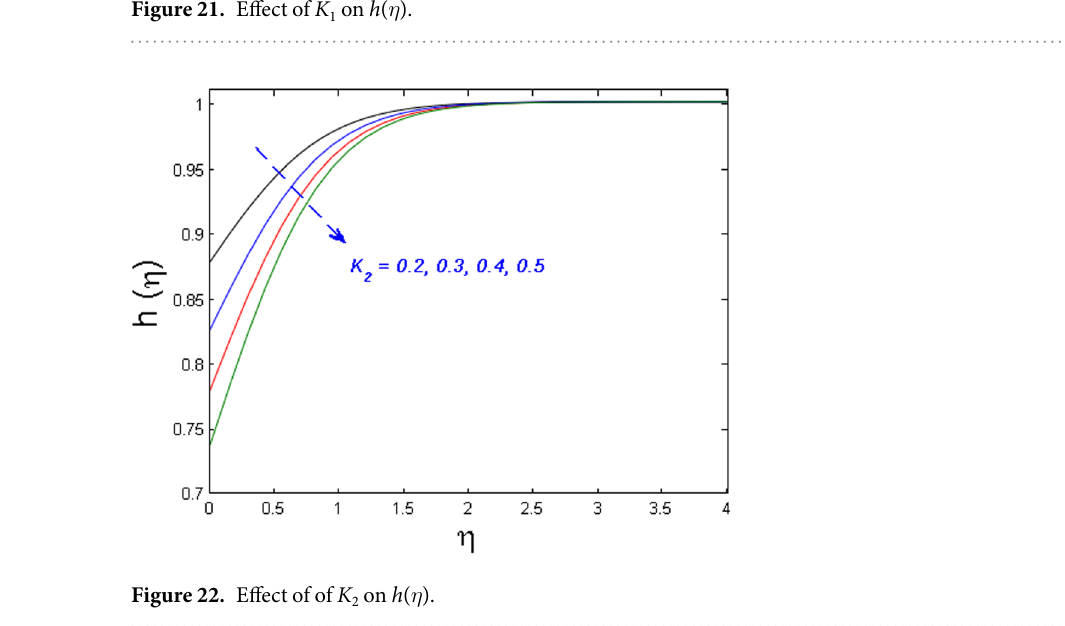
Figure 21. Effect of K 1 on h ( η ).